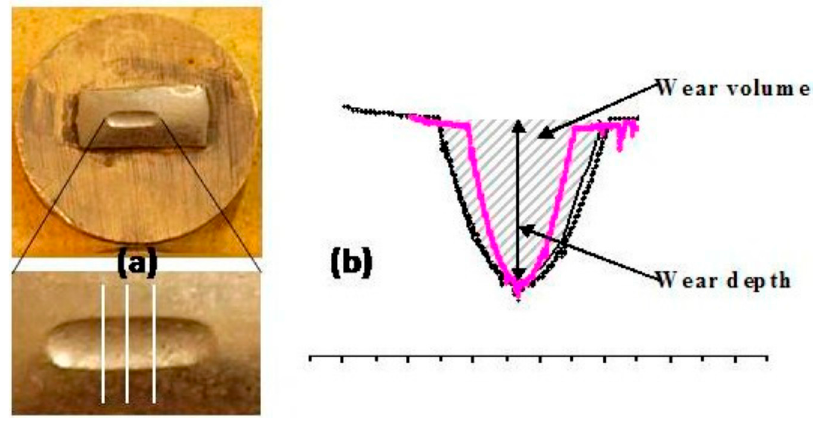
Figure 1. Wear facet produced by the reciprocating wear test method. The image was taken after gold coating of the mounted sample. If the material and environmental factors remain constant, the volume loss is linear with time, but the relationship of the wear volume and wear depth is not necessarily linear. ( a ) The white lines represent three estimated positions of the scans measured by the stylus profilometer and, ( b ) wear profiles from the reciprocation wear test showing same wear depth (purple line determined by the stylus profilometer), but different volume.